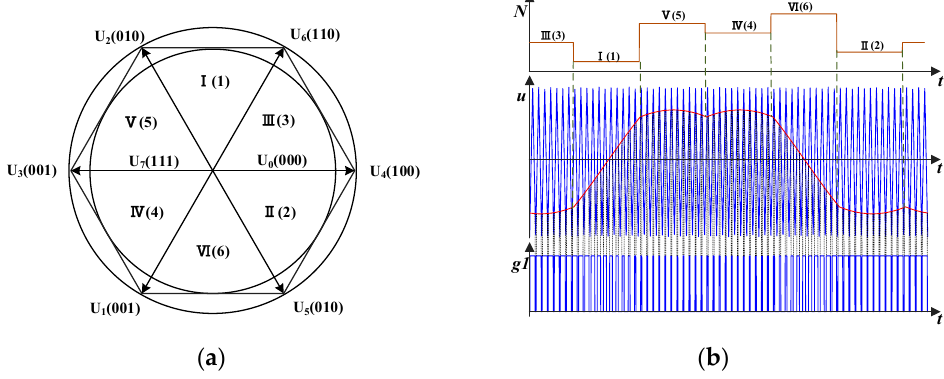
Figure 4. SVPWM algorithm implementation diagram: ( a ) voltage vector space diagram; ( b ) schematic diagram of PWM pulse signal generation.